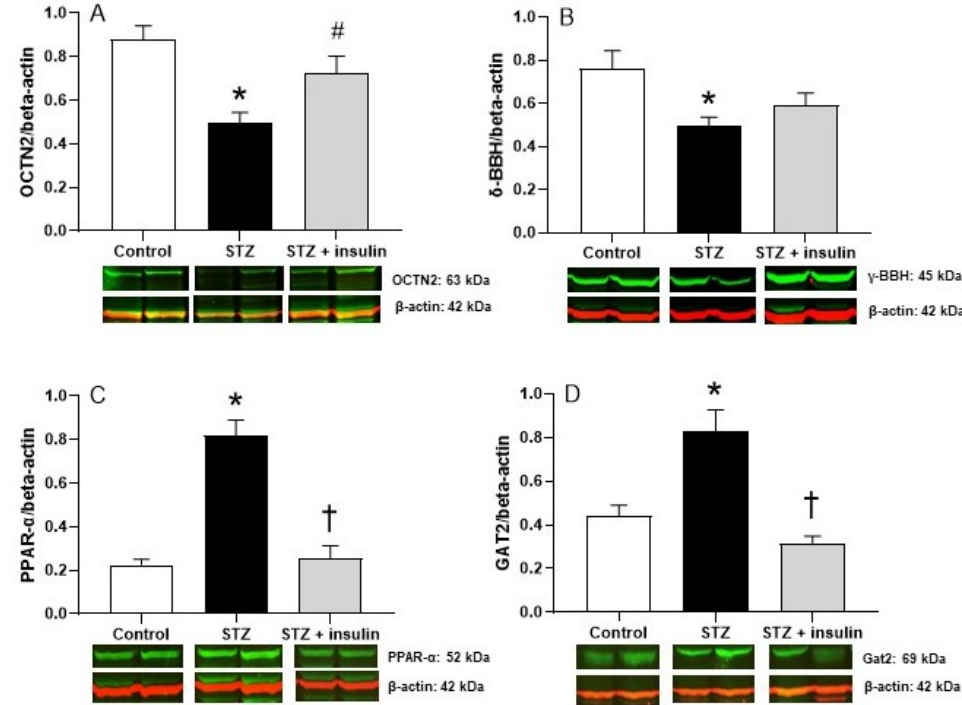
Figure 3. The effects of STZ-induced diabetes and insulin treatment on OCTN2 ( A ), γ -BBH ( B ), PPAR- α ( C ), and GAT2 ( D ) in rat liver. STZ, streptozotocin; γ -BBH, gamma-butyrobetaine hydroxylase; OCTN2, novel organic anion transporter; PPAR- α , peroxisome proliferator-activated receptor-alpha; GAT2, gamma-aminobutyric acid transporter. Protein expression levels were normalized using β -actin as an internal control. Values are reported as mean ± SEM for 4–6 kidneys from two independent experiments. * p < 0.05 compared to control rats. # p = 0.0507 compared to STZ rats ( A ). † p < 0.05 compared to STZ